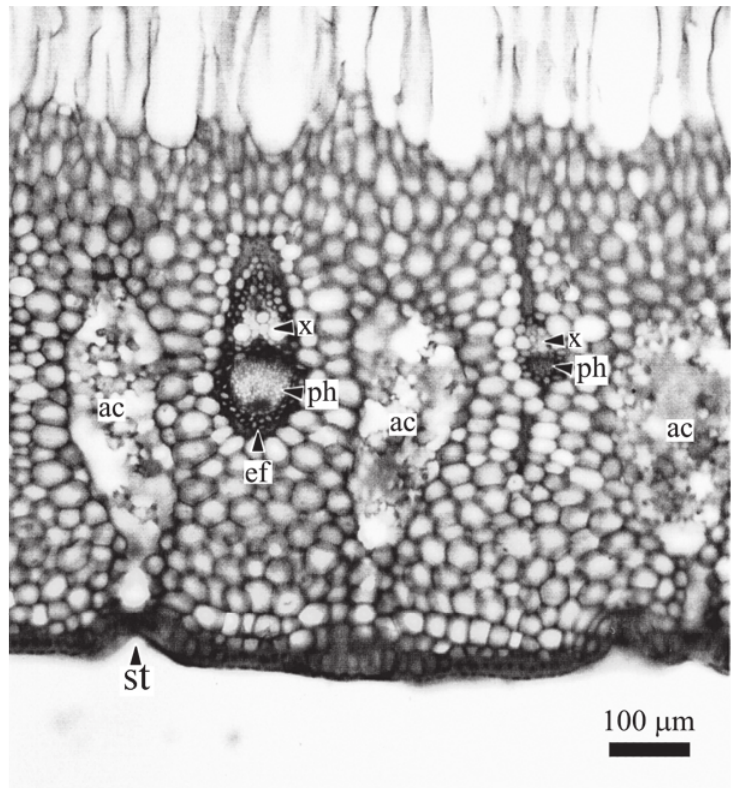
Figure 7 - Transversal section of Neoregelia cruenta leaf, in detail the chlorenchyma tissue, vascular bundles and aerial channels. ac - aerial